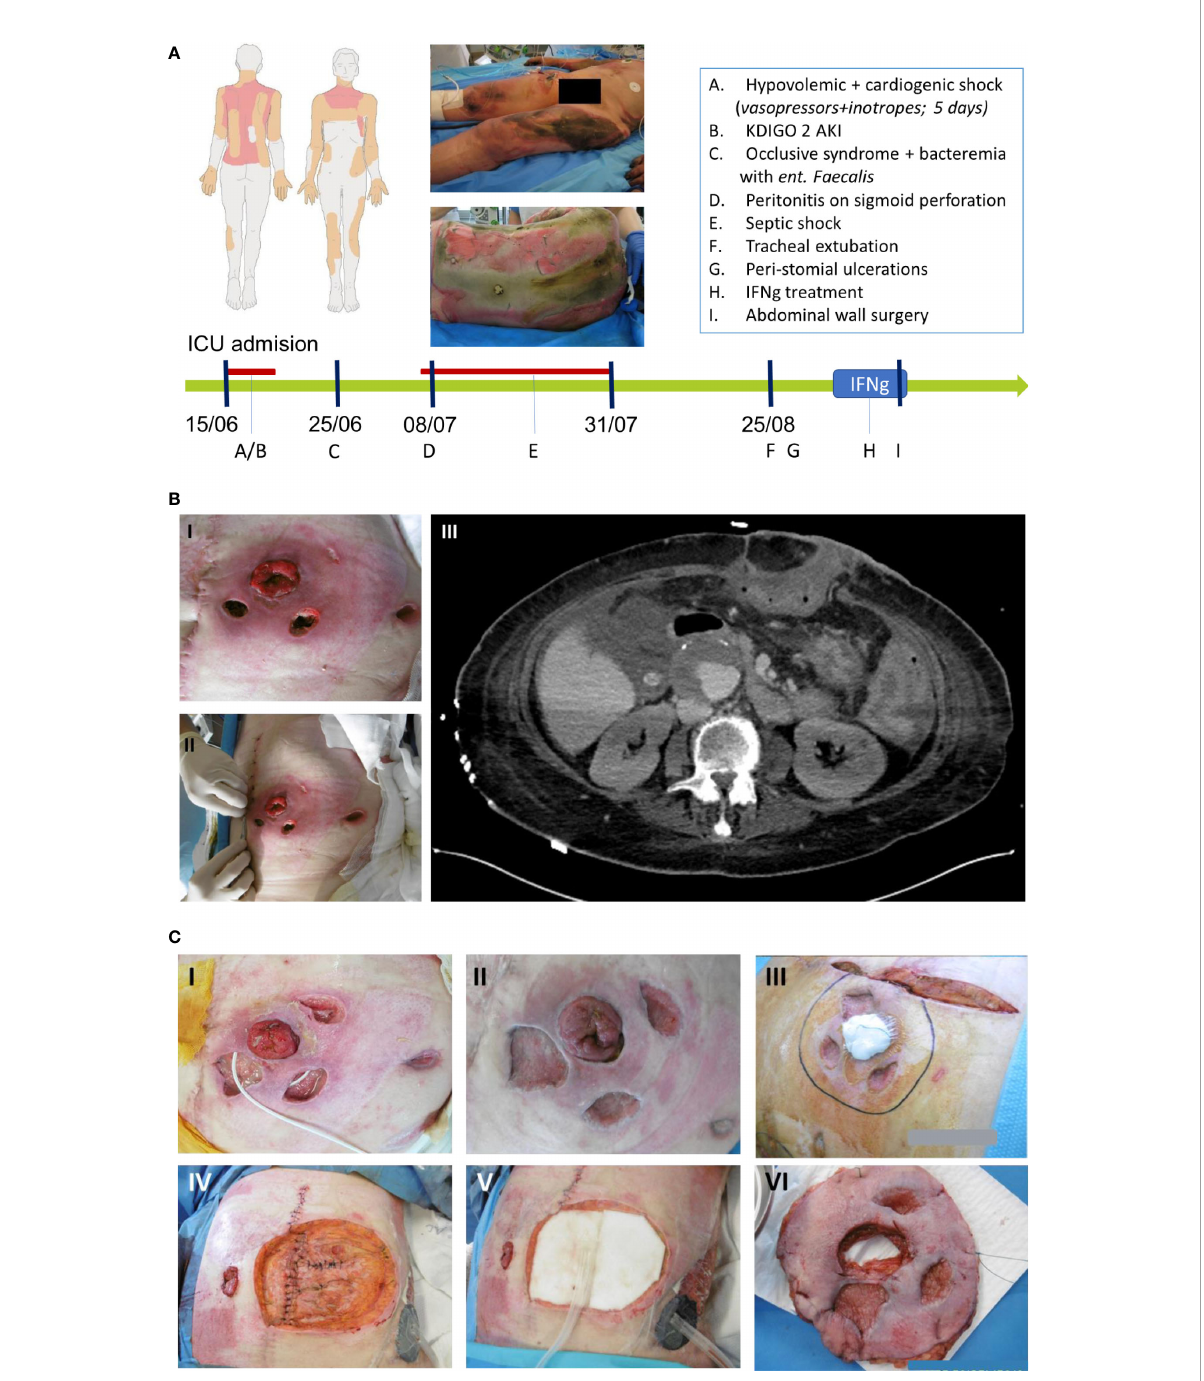
FIGURE 1 (A) Burn map of the burn injuries sustained by the patient, and timeline of events incurred by the case in Intensive Care Unit (ICU) represented by the green arrow while the red line represents the duration of vasopressors administration. (B) Mucormycosis of the abdominal wall. (B.I.) and (B.II.) Show peristomial ulcerations. (B.III.) Horizontal abdominal scan assessing the intra-abdominal extension of the cellulitis. (C) Evolution and healing of the abdominal lesions in response to IFN- g treatment. (C.I.) Lesions before IFN- g treatment. (C.II.) and (C.III.) Lesions after 6 days of IFN- g and right before surgery. (C.IV.) (C.V.) and (C.VI.) Excision of the abdominal wall and the transposition of the